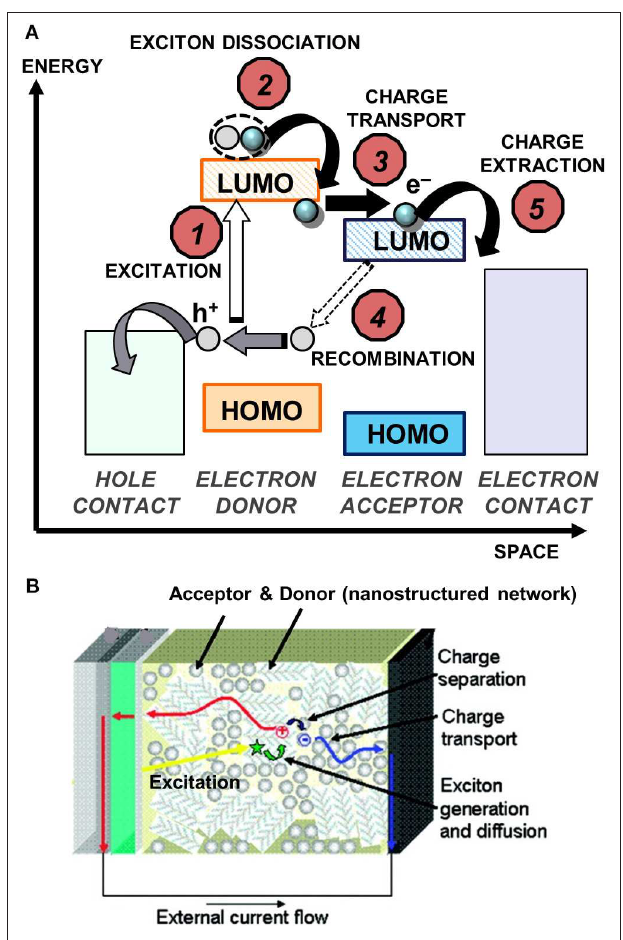
FIGURE 3 | (A) An illustration of the charge generation by photoexcitation, exciton dissociation, charge carrier transport, and recombination and extraction processes required to extract free charge after a photoexcitation event in organic semiconductor (OSC) materials. (B) A schematic illustration of a nanostructured network employed to promote transport and restrict recombination. Figure adapted with permission from Clarke and Durrant [ 37]. Copyright 2010 by American Chemical